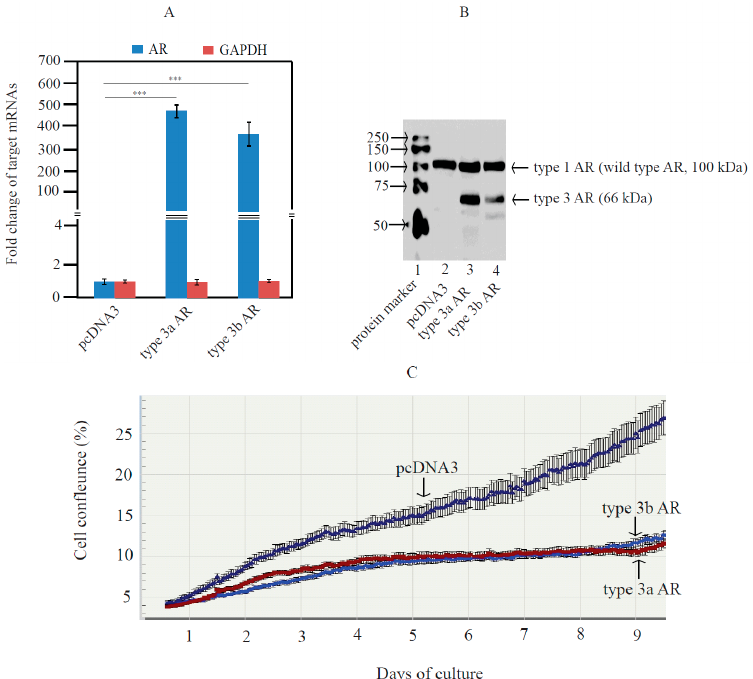
Figure 6. Type 3a and type 3b AR variants inhibit androgen-induced growth of LNCaP cells. ( A ) mRNA levels of type 3a or 3b AR as measured by qRT-PCR in control LNCaP cells and LNCaP cells stably expressing type 3a or 3b AR; Data shown are means ± SEM of fold changes of variant transcript levels in LNCaP cells stably expressing type 3a or 3b AR compared to the variant transcript levels in control LNCaP cells expressing no ectopic proteins from three independent experiments in triplicate.